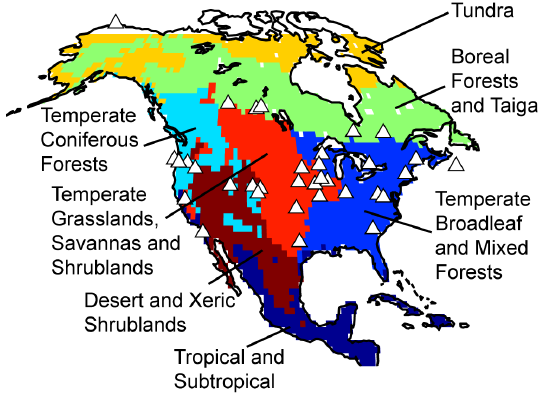
Figure 1. North American biomes, modified from Olson (2001), as defined for the case studies; white triangles indicate the locations of atmospheric CO 2 measurement towers used in the